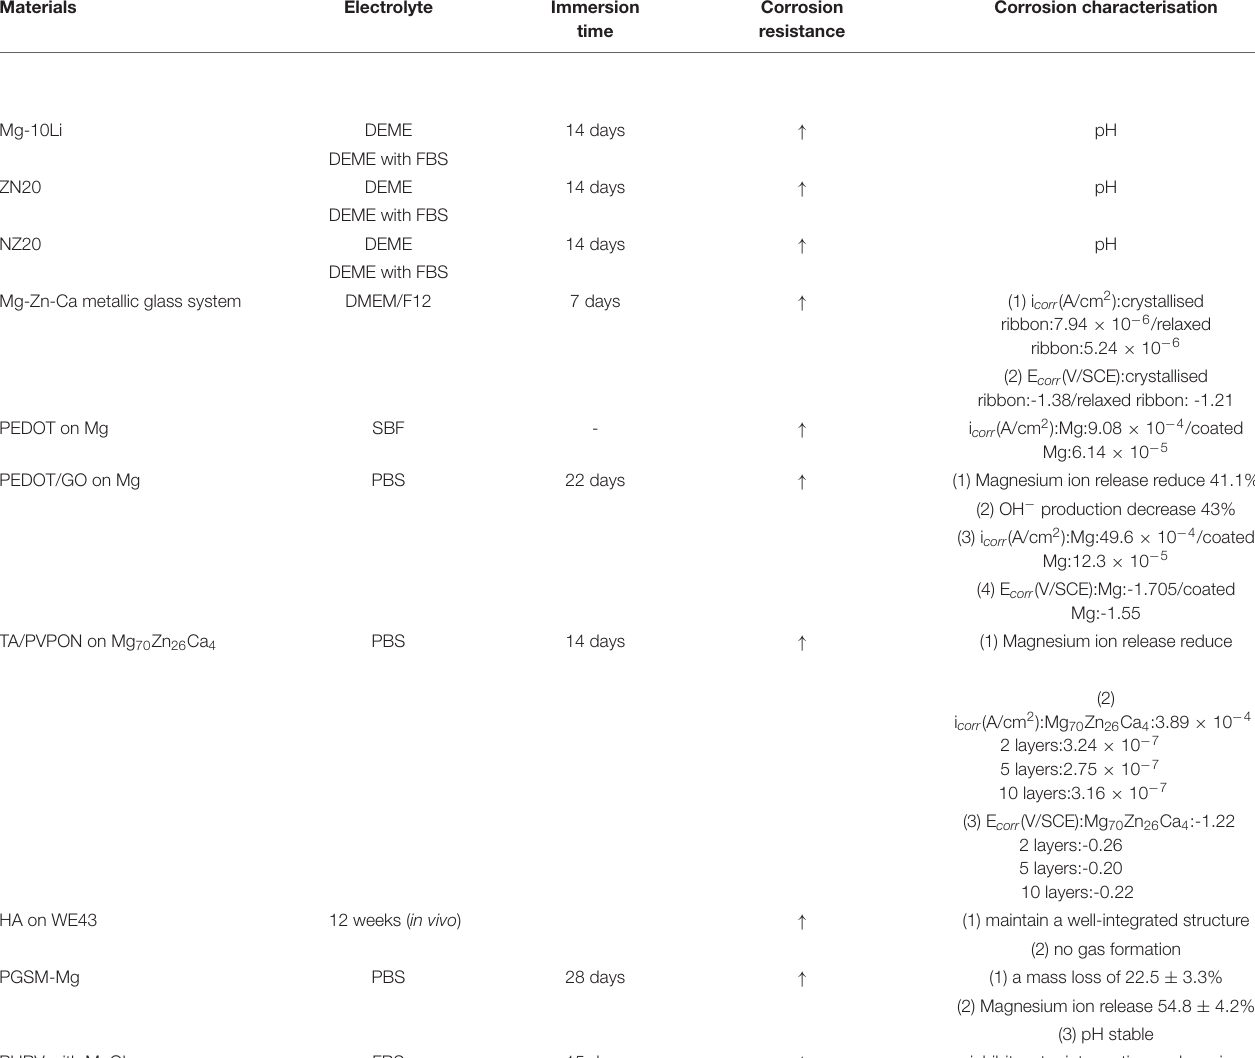
TABLE 1 | The corrosion resistance improvement of Magnesium. Materials Electrolyte Immersion